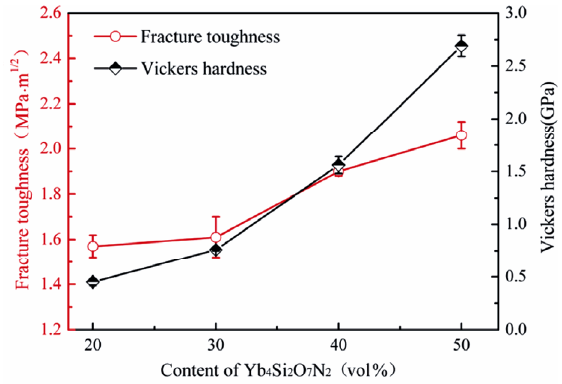
Fig. 5 Fracture toughness and Vickers hardness of h -BN/Yb 4 Si 2 O 7 N 2